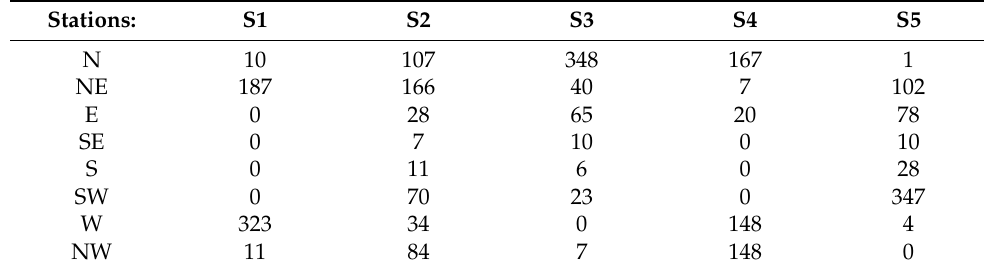
Table 4. Number of storm wave events per direction in the five selected